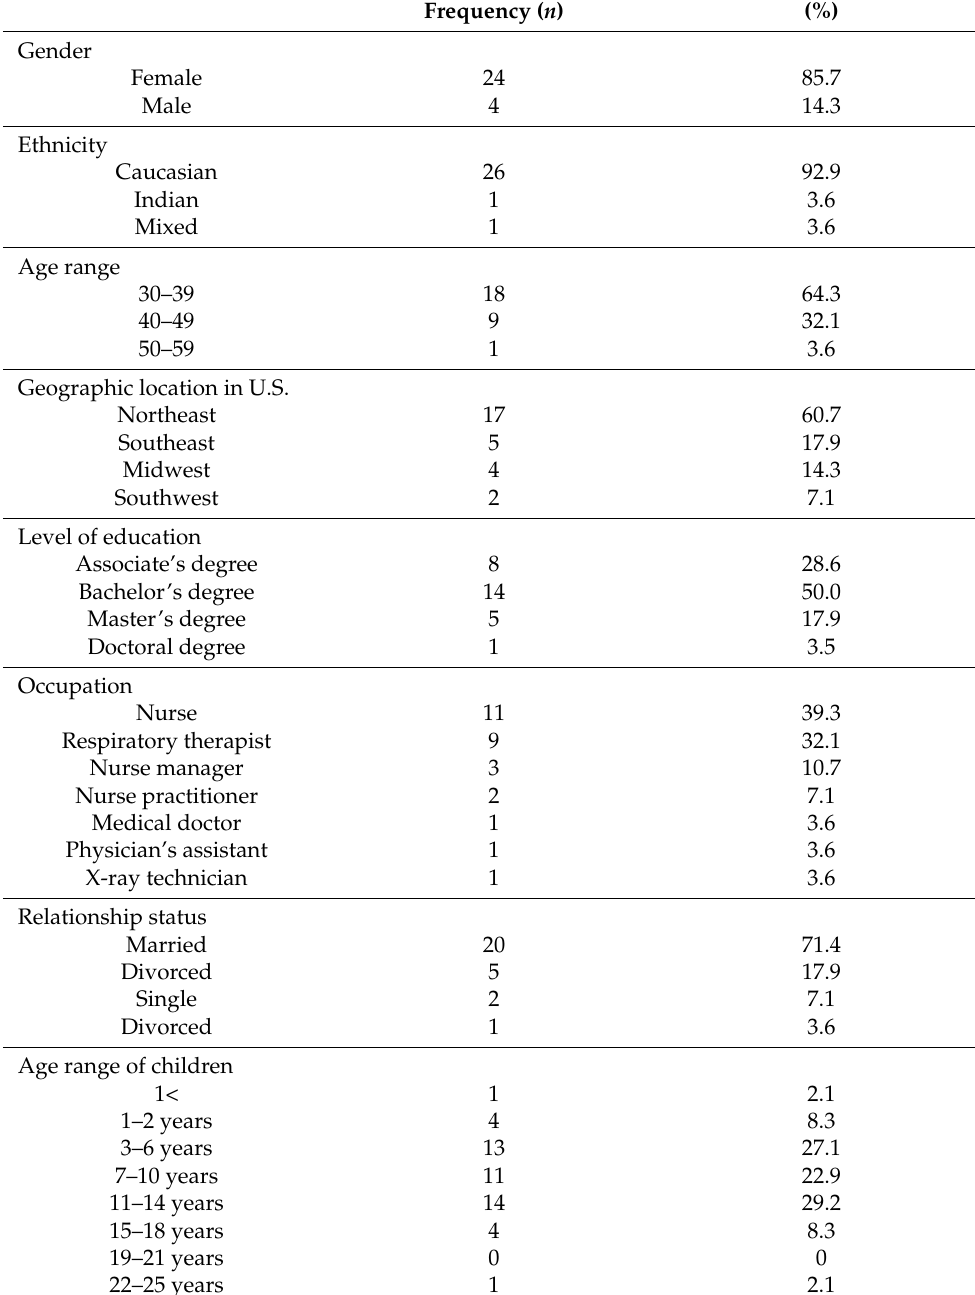
Table 1. The participants’ demographic information ( n =